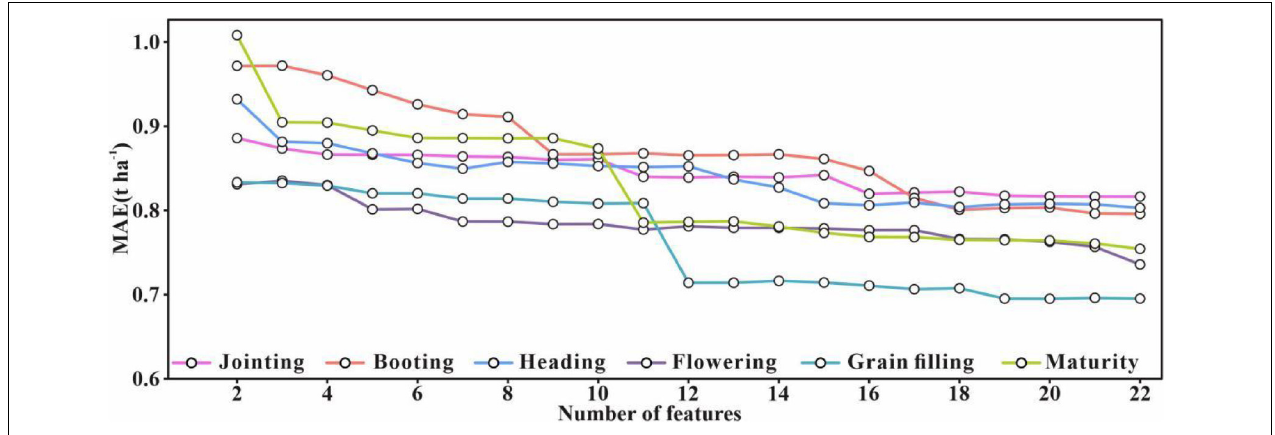
FIGURE 4 | Model training error as a function of the number of features. The order of input of features depends on the gray relational degree (GRD). MAE, mean absolute error.